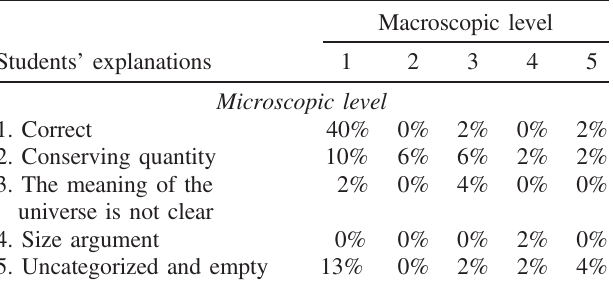
TABLE VII. Cross tabulation of students ’ explanations con- cerning changes in entropy and in the number of accessible microstates for the Universe (items 1d and 2d). N ¼ 48 . Categories 1 – 5 are the same in columns and rows but for macroscopic (columns) and microscopic (rows)